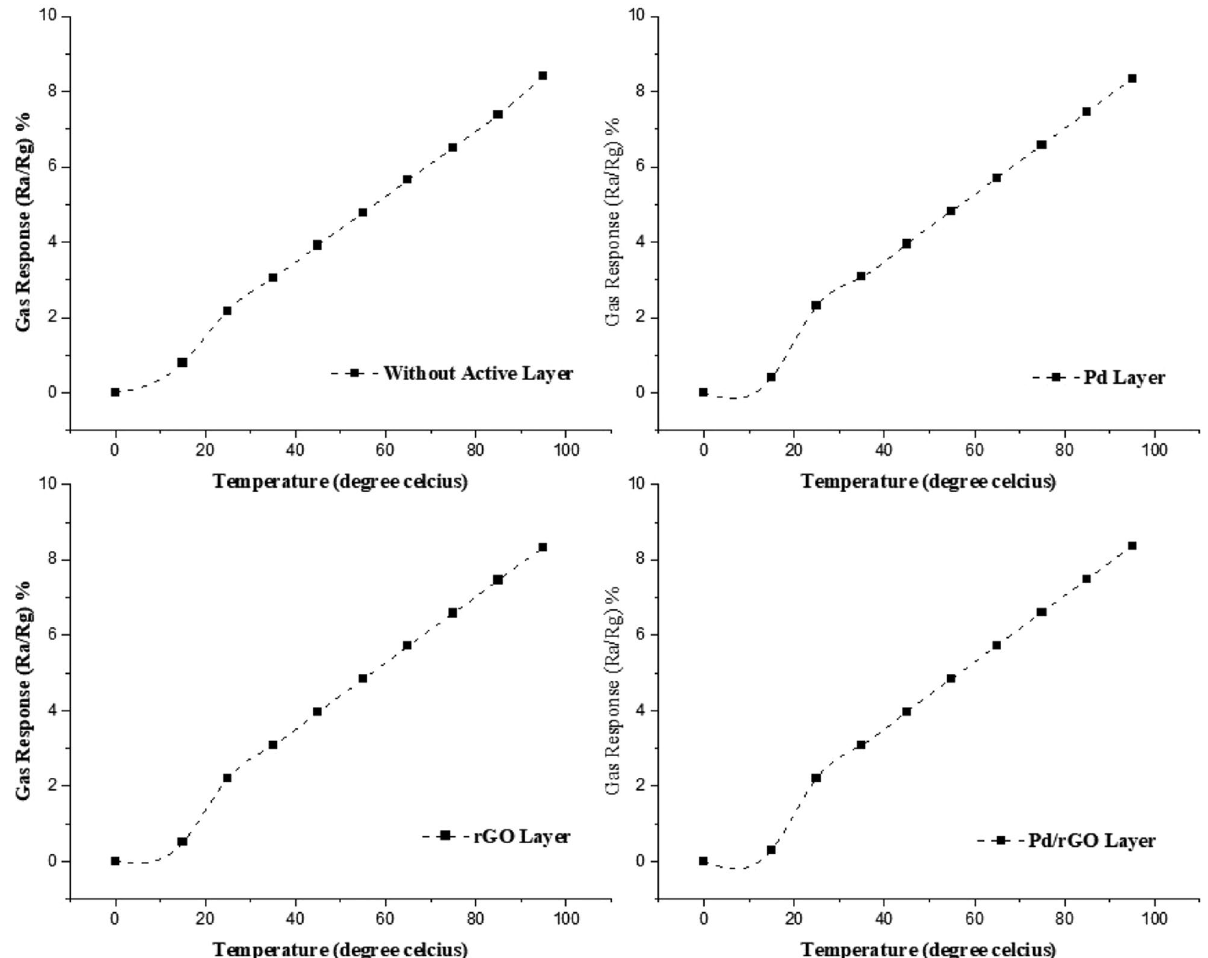
Figure 18. The simulated results of response at various working